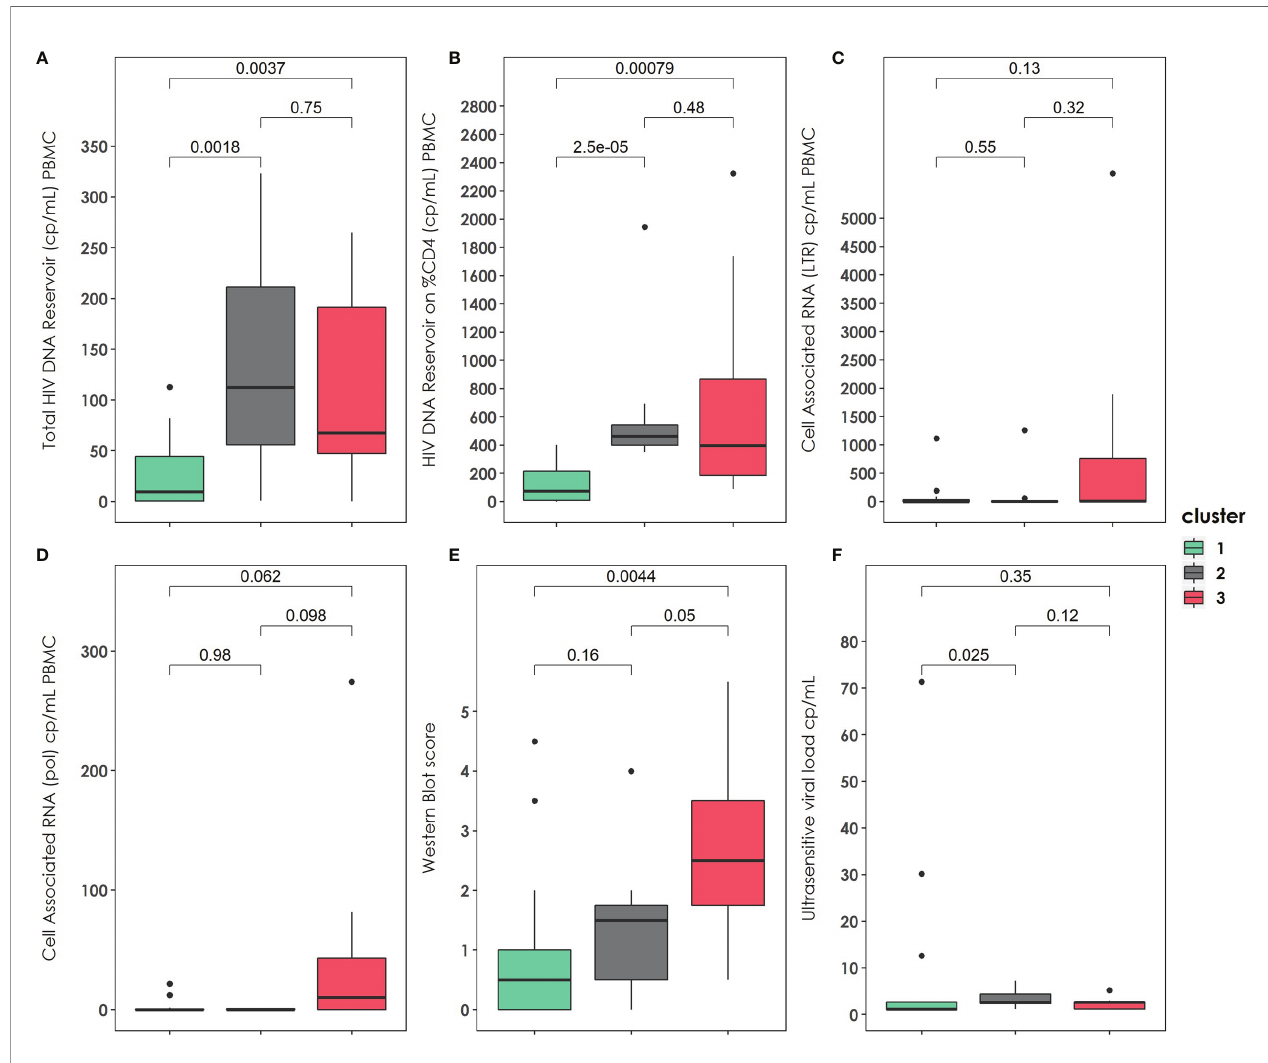
FIGURE 3 | Virological characteristics and Western-Blot score of the three clusters described at the end of the follow up. (A) Total HIV reservoir size (copies/mL) on PBMC distribution among the clusters. (B) HIV DNA reservoir size on %CD4 distribution among the clusters. (C) Cell Associated RNA at LTR region (copies/mL) distribution among the clusters. (D) Cell Associated RNA at pol region (copies/mL distribution among the clusters). (E) Western blot score distribution among the clusters. (F) Ultrasensitive viral load measurement distribution among the clusters. PBMC: peripheral blood mononuclear cell. P-values were calculated using U-Mann Whitney Test and Kruskal-Wallis test when